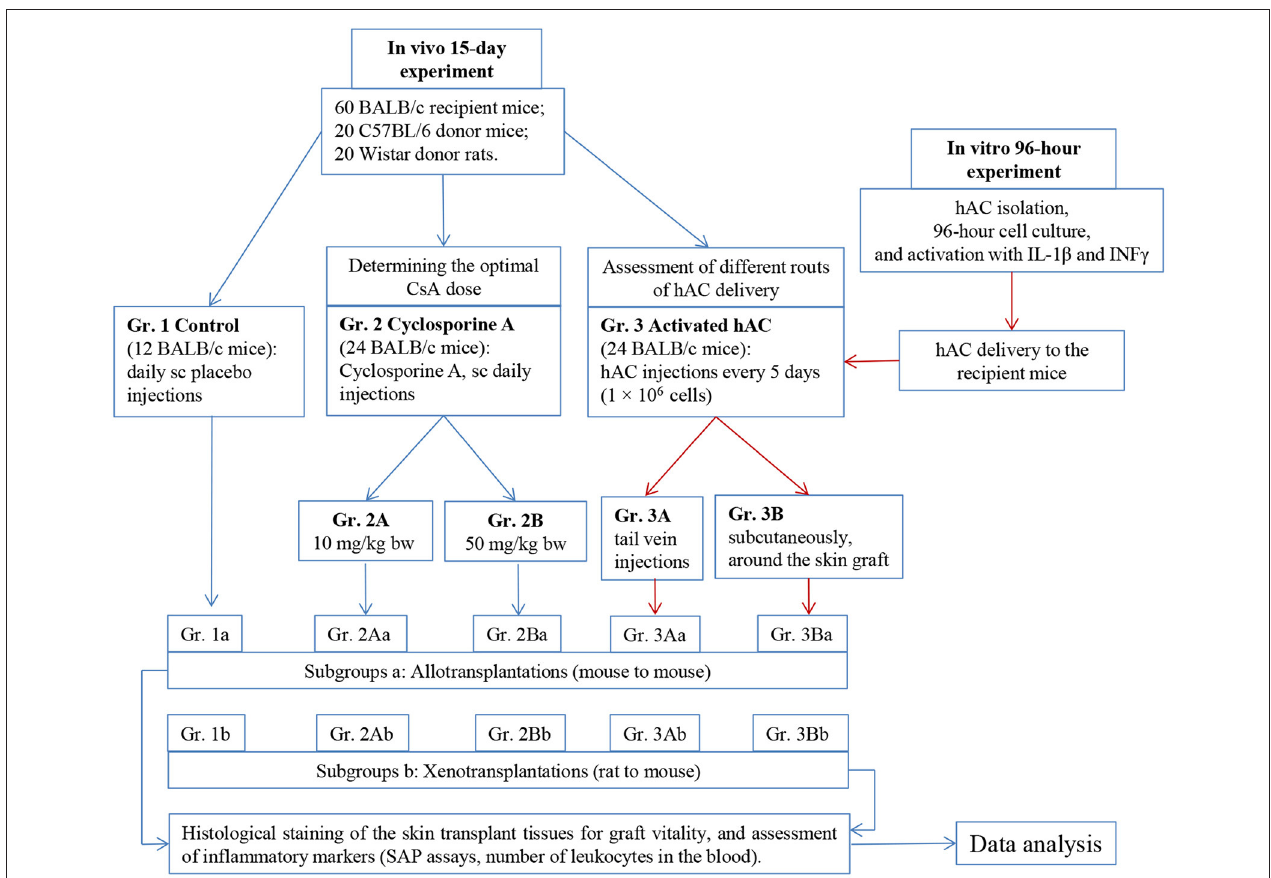
FIGURE 1 | Outline of the work plan. Sc, subcutaneous injections; bw, body